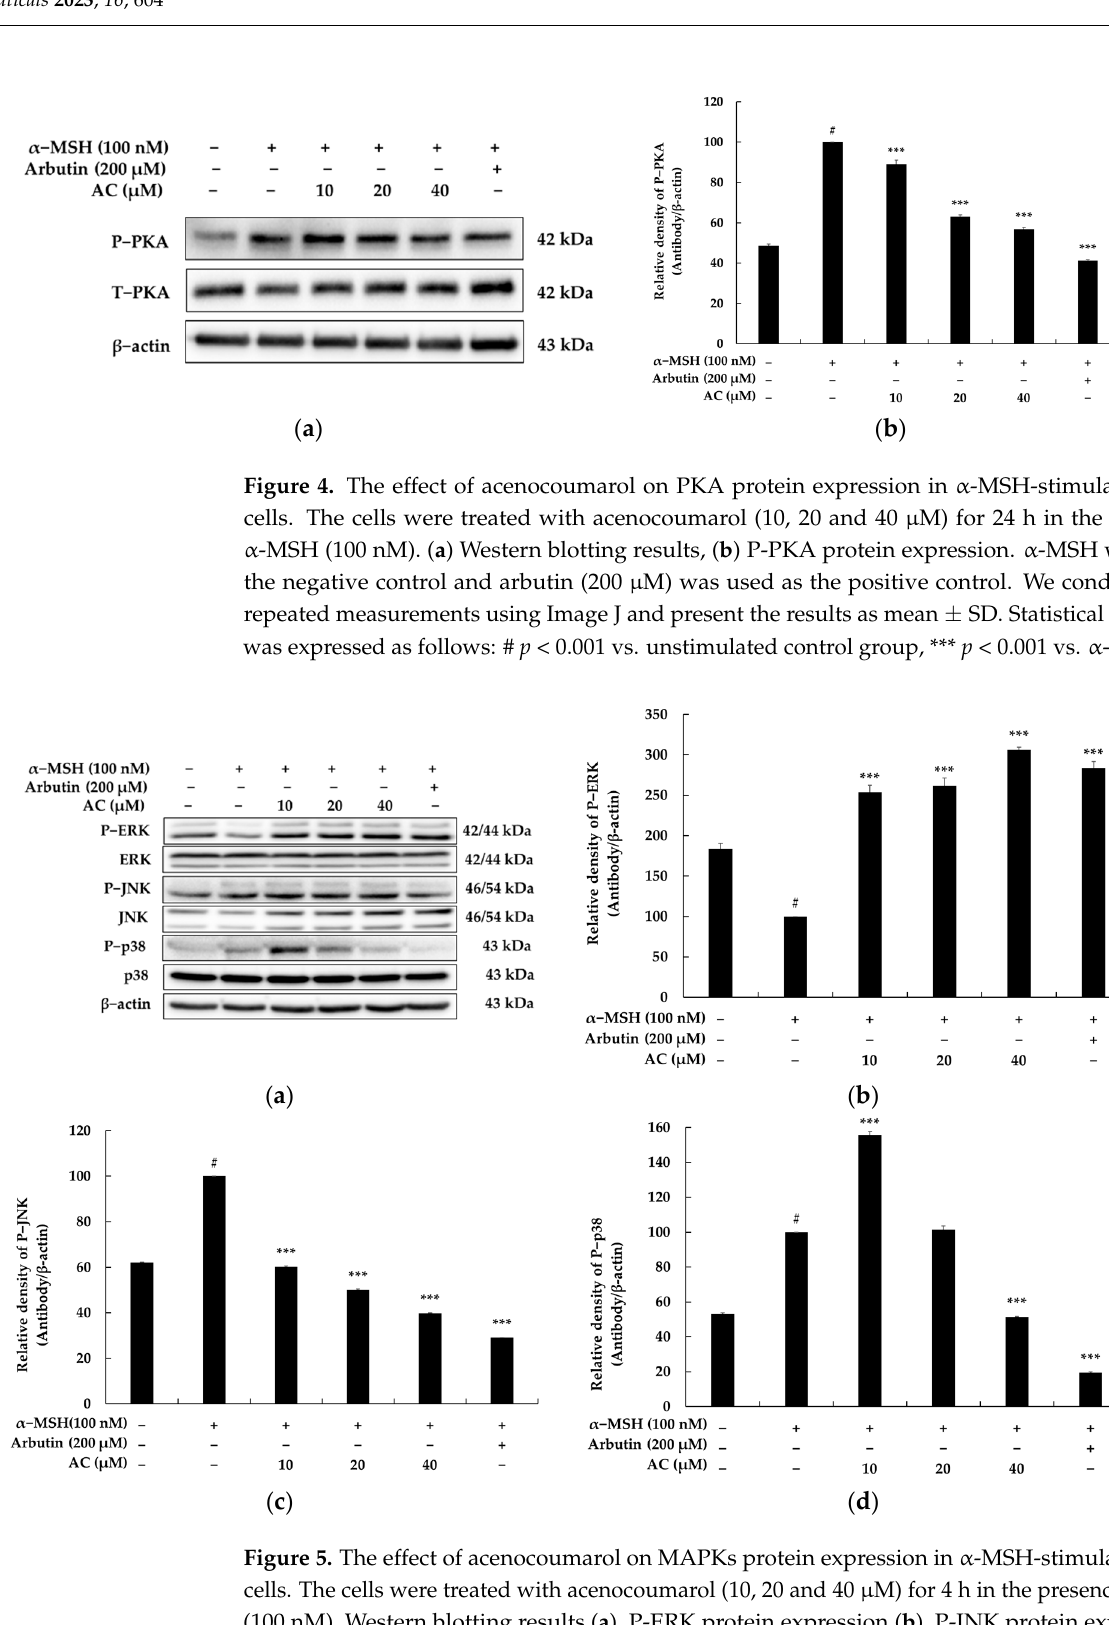
( f ) Figure 3. The e ff ect of acenocoumarol on tyrosinase, TRP − 1, TRP − 2, and MITF protein expression in α− MSH-stimulated B16F10 cells. α− MSH was used as the negative control and arbutin (200 μ M) was used as the positive control. ( a , b ) Protein expression levels of TYR, TRP-1, TRP-2, and MITF were determined by Western blot following with acenocoumarol (10, 20 and 40 μ M) treatment for 48 h in the presence of α− MSH (100 nM). The densitometric analysis of TYR ( c ), TRP-1 ( d ), TRP-2 ( e ), and MITF ( f ) using Image J and present the results as mean ± SD. Statistical significance was expressed as follows: # p < 0.001 vs. unstimulated control group, * p < 0.05, *** p < 0.001 vs. α− MSH alone. 2.2. Acenocoumarol Regulated the Expression of Melanogenic Proteins Three important melanogenic enzymes, tyrosinase, tyrosinase-related protein (TRP)- 1, and TRP-2, are required for the proper production of melanin synthesis. The study in- vestigated the mechanisms by which acenocoumarol inhibits melanogenesis in B16F10 cells. The expression of three enzymes involved in melanogenesis, namely tyrosinase, TRP-1, and TRP-2, is regulated by a master regulator, MITF [18,19]. The study found that acenocoumarol decreased the protein expression of tyrosinase, TRP-1, TRP-2, and MITF in B16F10 cells, indicating that the inhibition of melanogenesis by acenocoumarol is me- diated by the downregulation of these enzymes via MITF (Figure 3). 2.3. Acenocoumarol Inhibited Melanogenesis through the PKA Signaling Pathway The expression of the MITF gene, which is mediated by PKA signaling, upregulates the expression of critical factors in melanogenesis, including tyrosinase, TRP-1, and TRP- 2, in a sequential manner [20]. Therefore, having demonstrated that acenocoumarol can induce the expression of MITF, tyrosinase, TRP-1, and TRP-2, we further investigated